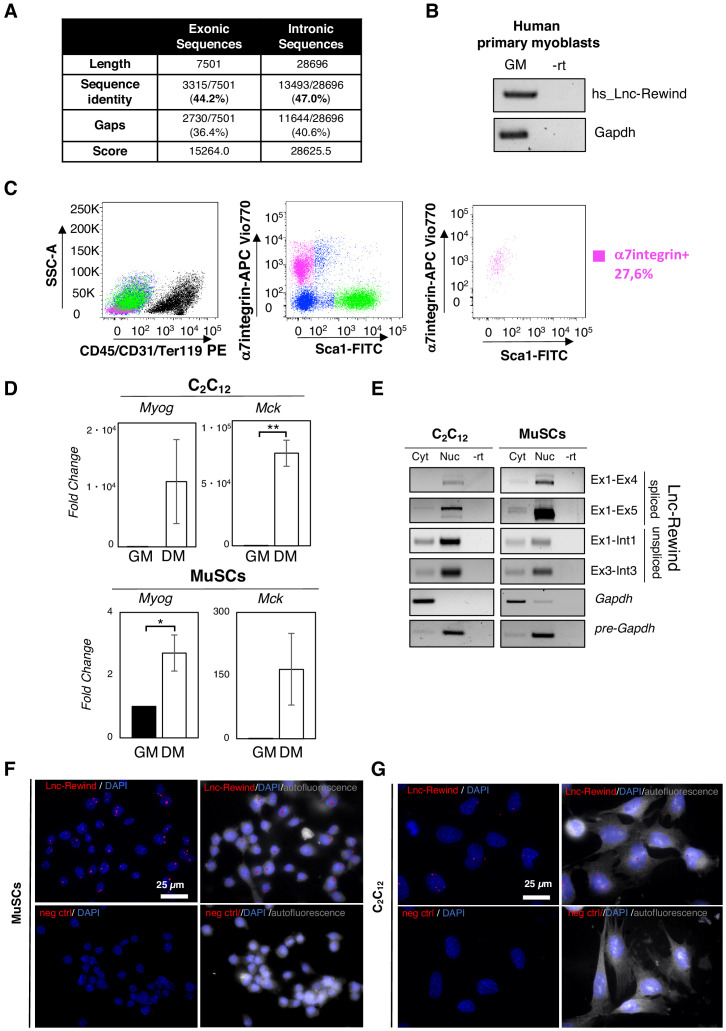
Lnc-Rewind is a conserved chromatin-associated lncRNA expressed in satellite cells.(A) Table represents the values obtained by analysing the local sequence alignment between the human and murine Lnc-Rewind transcripts. Data were produced by using the implementation of the Smith–Waterman algorithm available at http://www.ebi.ac.uk/Tools/psa/emboss_water/. (B) Semiquantitative RT-PCR (sqRT-PCR) quantification of the human hs_Lnc-Rewind transcript in proliferating (GM) myoblasts from a healthy donor. Mature Gapdh was used as endogenous control. (C) FACS plot showing MuSC isolation strategy from WT mice. MuSCs are isolated, among the lineage (CD45/CD31/Ter119) negative cells, as α7integrin+/Sca1− cells (magenta box) (left and middle panels). The right plot shows the check purity of sorted MuSCs. (D) qRT-PCR quantification of Myog and Mck in C2C12 and MuSC-derived myoblasts in growth (GM) and differentiated (DM) conditions. Data represent the mean ± SEM of three biological replicates and were normalized on Gapdh mRNA. (E) sqRT-PCR quantification of Lnc-Rewind, using different primers, in cytoplasmic (Cyt) and nuclear (Nuc) fractions from proliferating C2C12 and MuSC-derived myoblasts. The quality of fractionation was tested with mature (Gapdh) and precursor (pre-Gapdh) RNAs. –rt represents the negative control (F) Representative 60X confocal images of MuSC-derived myoblasts cell cultures hybridized with probes set specific for Lnc-Rewind (upper panels) and for a human mRNA (dlc1), as negative control (neg ctrl) (bottom panels). Autofluorescence (gray) is shown with false colour to visualize the cell body. DAPI, 4’,6-diamidino-2-phenylindole (blue); scale bar: 25 μm. (G) Representative 60× confocal images of C2C12 cell cultures hybridized with probes set specific for Lnc-Rewind (upper panels) and for a human mRNA (dlc1), as negative control (neg ctrl) (bottom panels). Autofluorescence (grey) is shown with false colour to visualize the cell body. DAPI, 4’,6-diamidino-2-phenylindole (blue); scale bar: 25 μm. Data information: *p<0.05, unpaired Student’s t-test.Figure 1—figure supplement 1—source data 1.Source data for Figure 1—figure supplement 1.